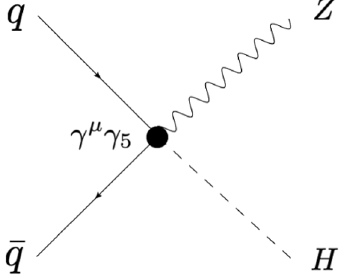
Figure 12 . The amendment term